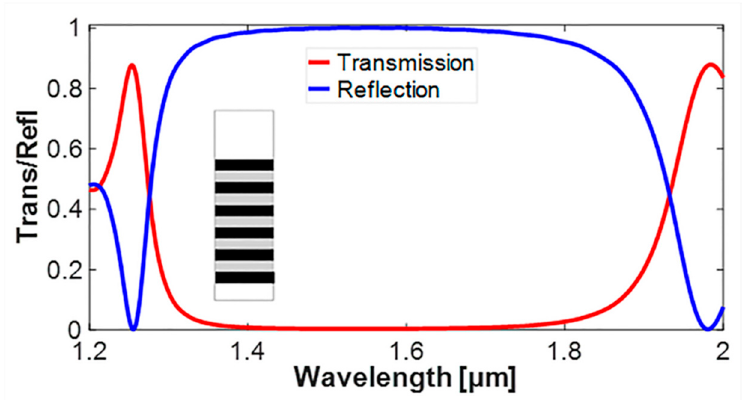
Figure 2. Output spectrum of the DBR structure where red (transmission) and blue (reflection) lines represent a stopband of 0.656 µm with λ c = 1.5 µm.